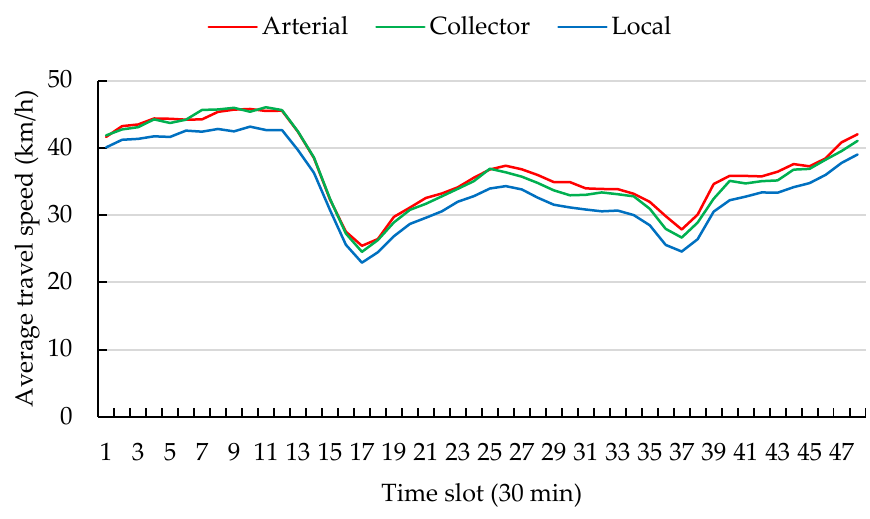
Figure 2. Traffic speed distribution at each time slot by road segment type.